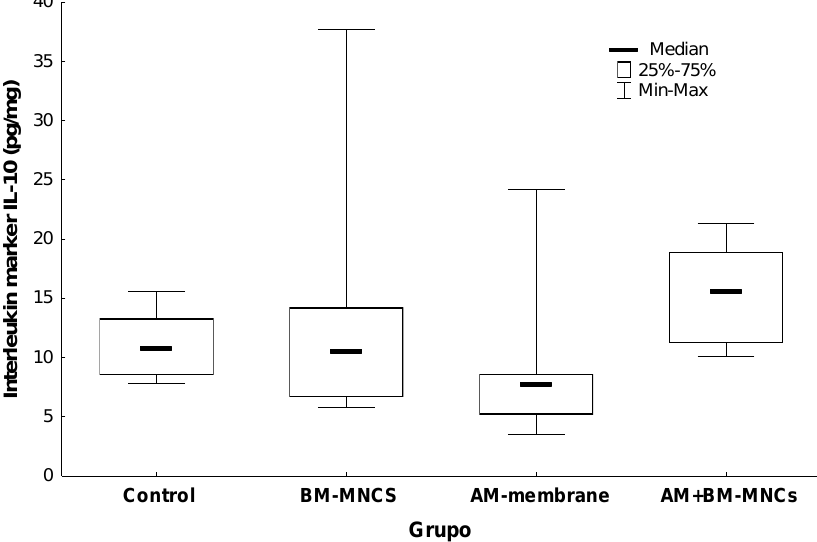
Figure 6. Effect of AM and BMSCs on Interleukin marker IL-10. Results are expressed as mean [interquartile range] ± SEM (N = 10). p < 0.05 denoted statistical significance in comparison to the control group. BMSCs: bone marrow mononuclear stem cells; AM : acellular human amniotic membrane.